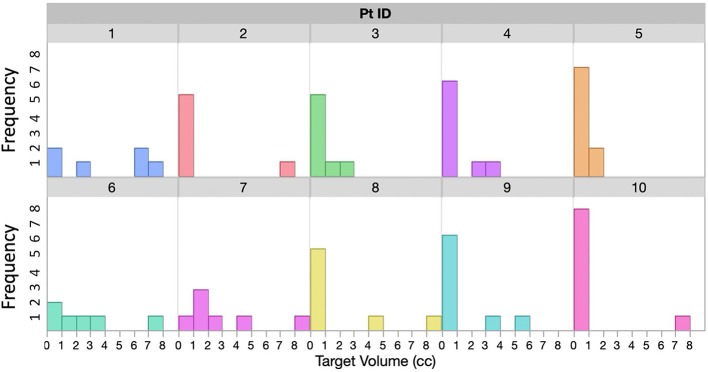
Distributions of tumor sizes for all 10 patients included in this study.